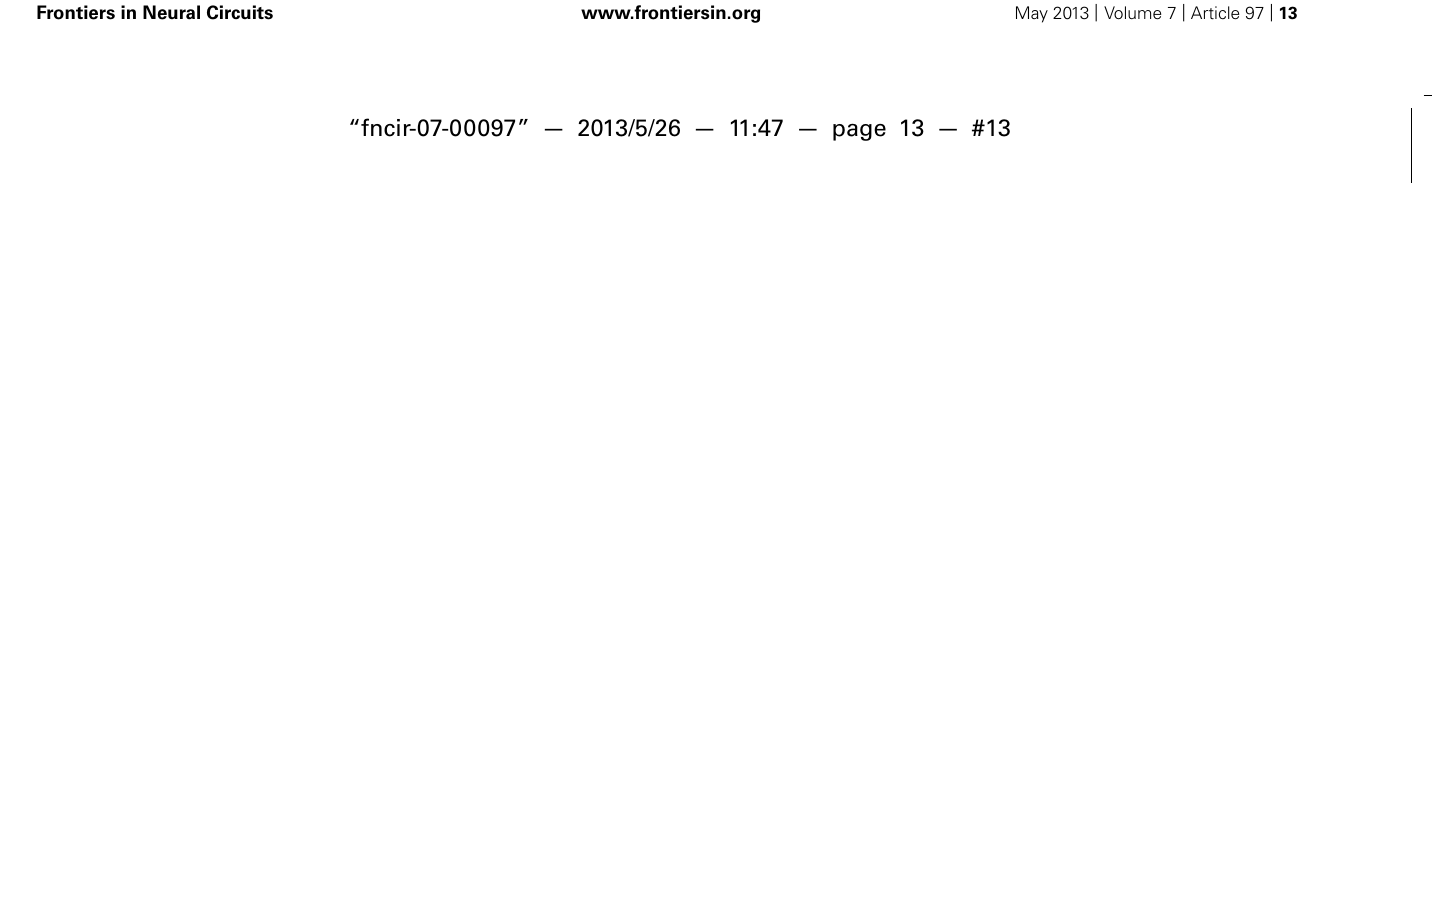
p < 0.0001), and in frontal cortex at P33 (3 τ = 32.9 ± 17.8; R = 0.77, p < 0.001). (B) Exponential decay functions were fit to the pre-synaptic:post-synaptic index in visual and frontal cortex, adult levels were defined as 3 τ . Pre-synaptic:post-synaptic index reached adult levels in visual at P25 (3 τ = 25.0 ± 15.0; R = 0.64, p < 0.05), and in frontal cortex at P86 (3 τ = 86.2 ± 35.0; R = 0.89, p < 0.0001). A weighted average curve was fit to somatosensory